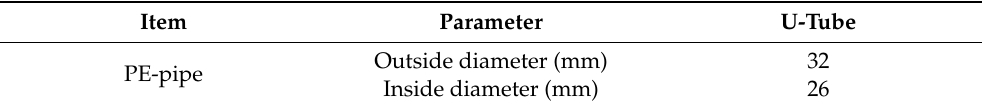
Table 3. Specific properties of the U-Tube.